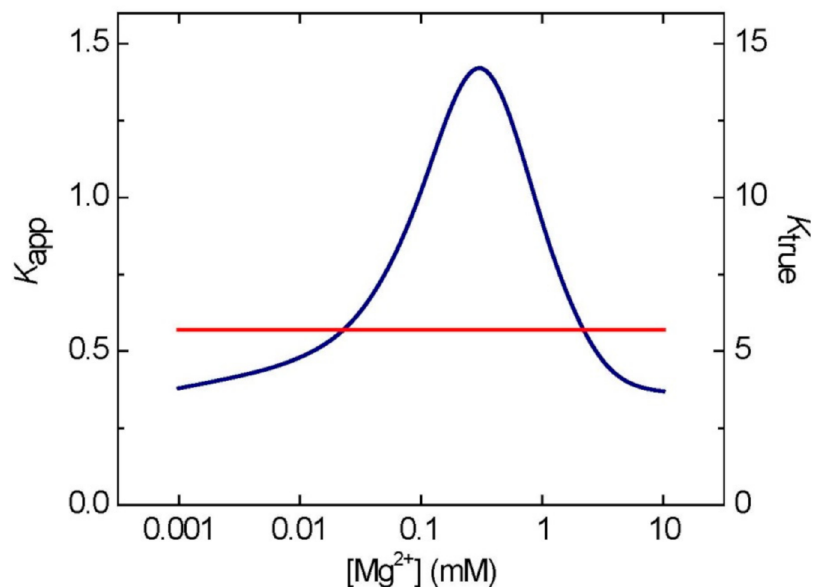
Figure 2. Effects of [Mg 2+ ] on K app and K true of AK. The K app peaks at ca. 0.2 mM Mg 2+ . Please note that the scale on X-axis is logarithmic. The lines for K app (blue) and K true (red) were computed as described in ref 55, using Origin software (OriginLab Corporation, Northampton, MA,